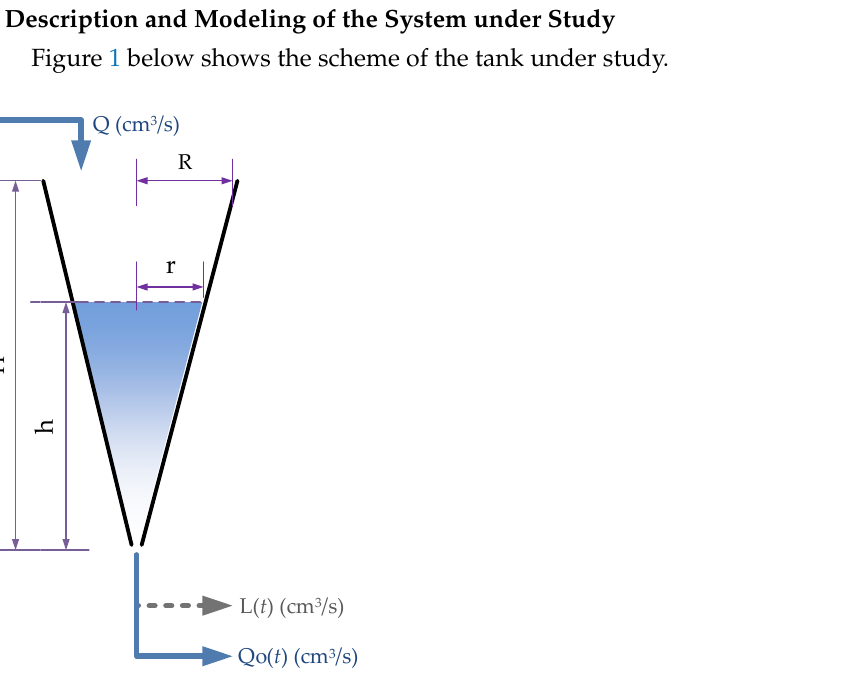
Figure 1. Physical diagram of the tank with an auxiliary output L( t ).